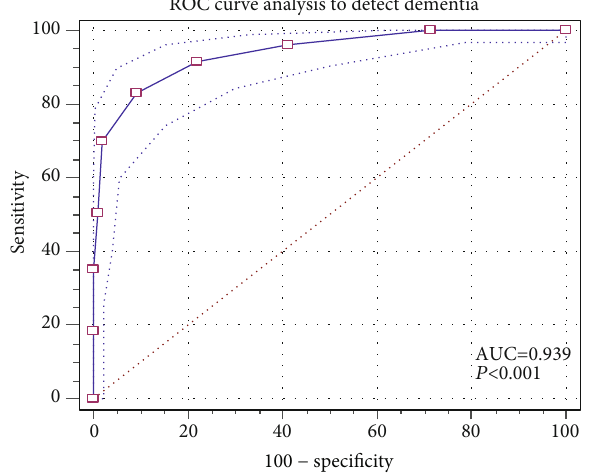
Figure 1: Receiver operating curve (ROC) of AD8-P to detect